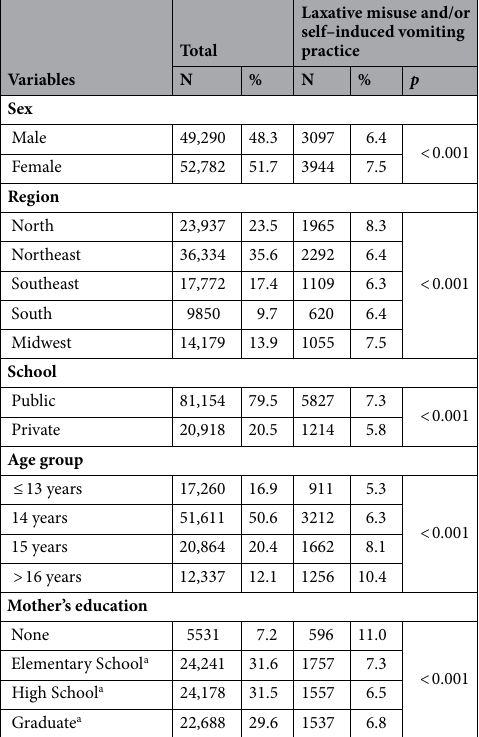
Table 1. Sociodemographic characteristics of participants as related to laxative misuse and/or self-induced vomiting practice. a Complete and incomplete educational